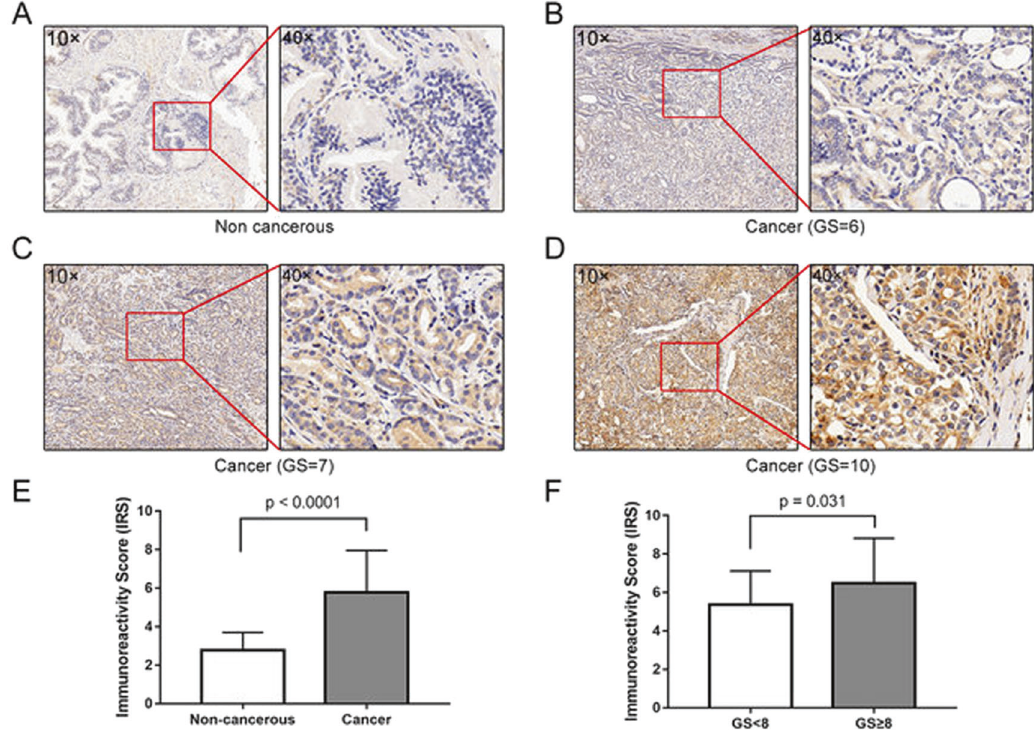
Fig. 1 Immunostaining of MAP1LC3B in PCa and normal prostate tissues. A Low expression of MAP1LC3B detected in normal prostate tissues. B – D High expression of MAP1LC3B detected in prostate cancer tissues. E , F Statistical analysis revealed MAP1LC3B was lowly expressed in non-cancerous prostate tissues, whereas highly expressed in PCa tissues, and correlated positively with Gleason